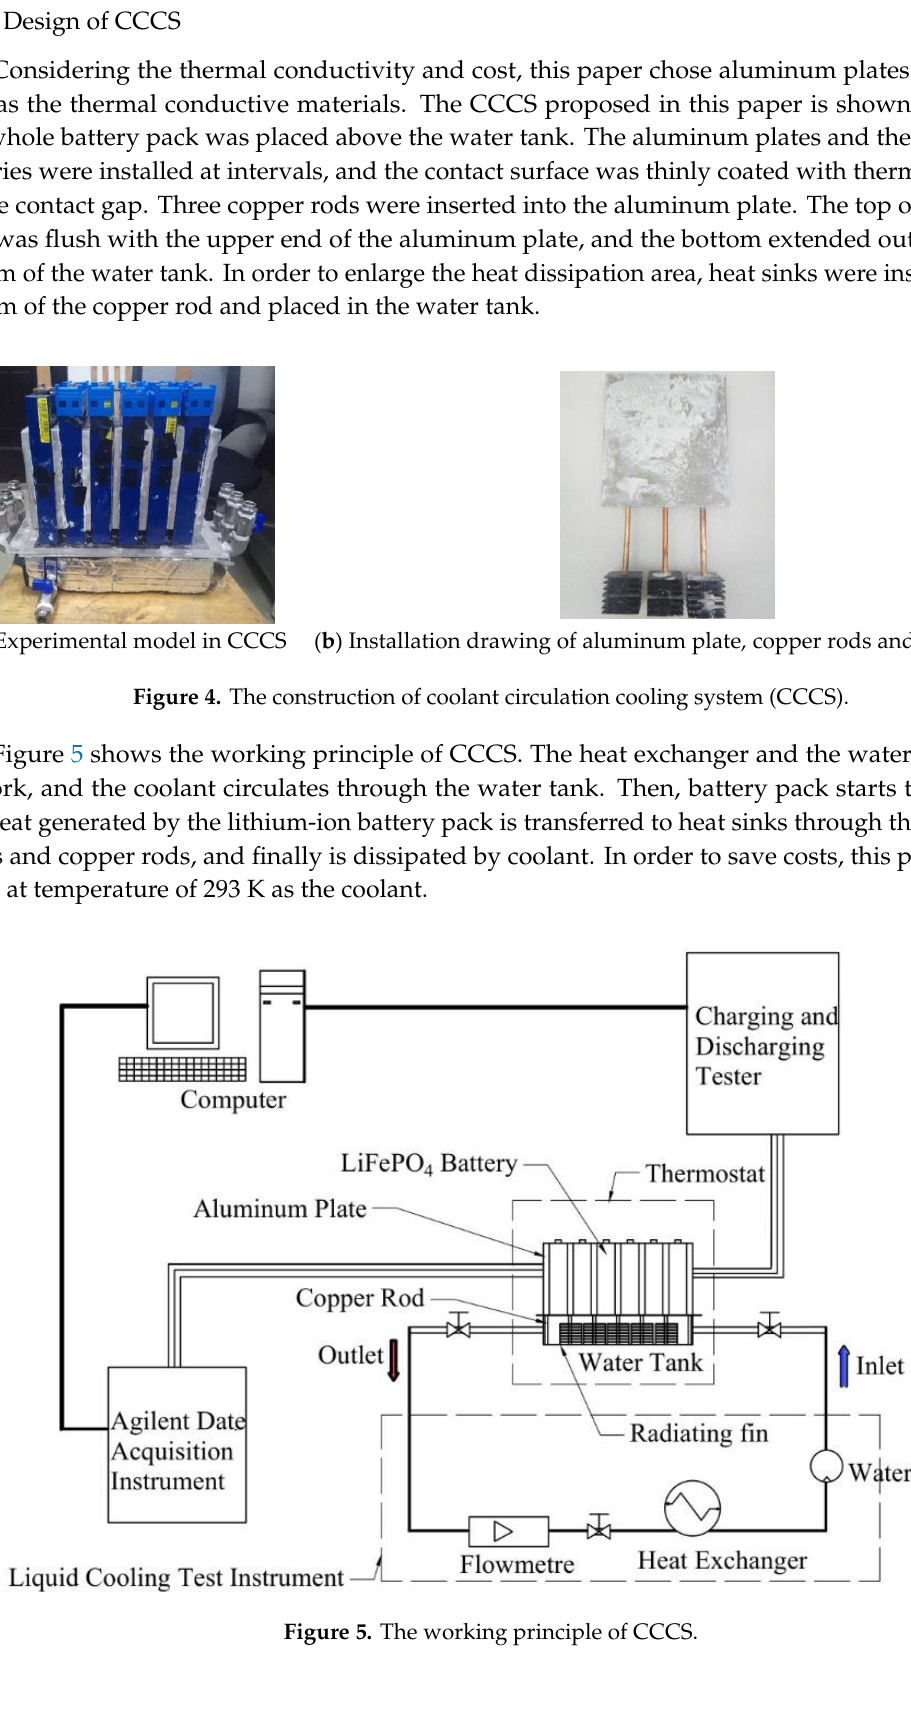
Figure 5. The working principle of CCCS.